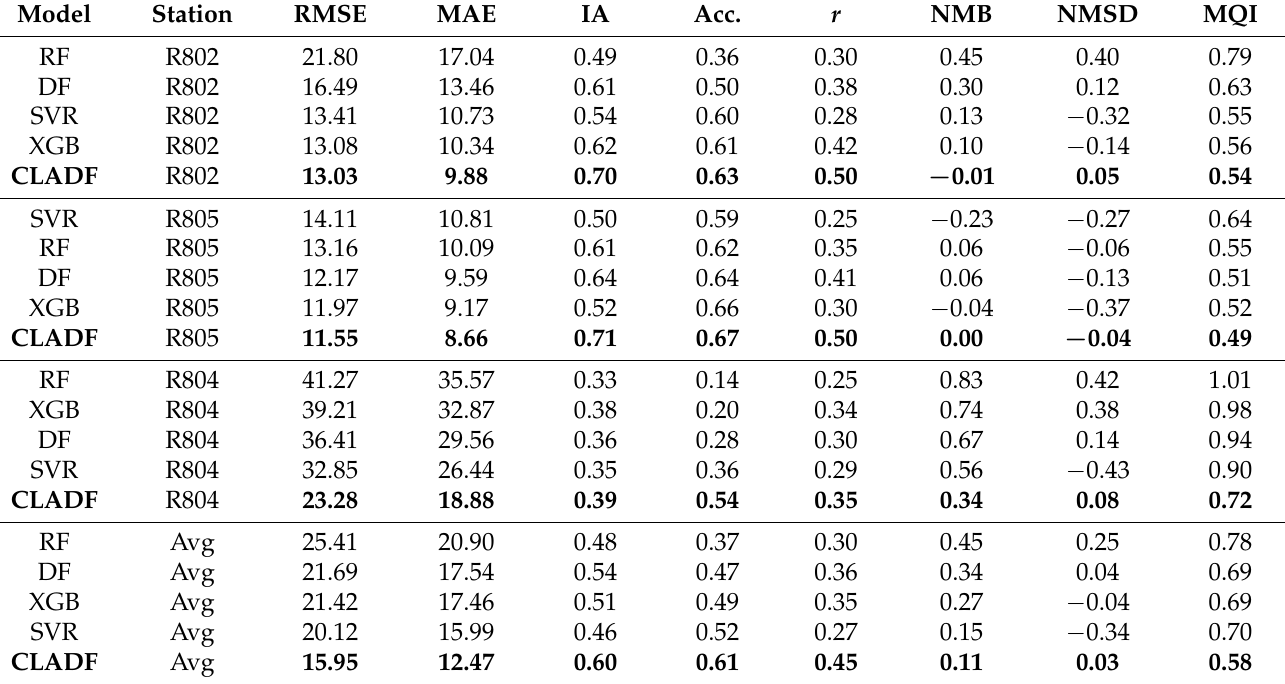
Table 3. Comparison of performance metrics of methods at three different reference